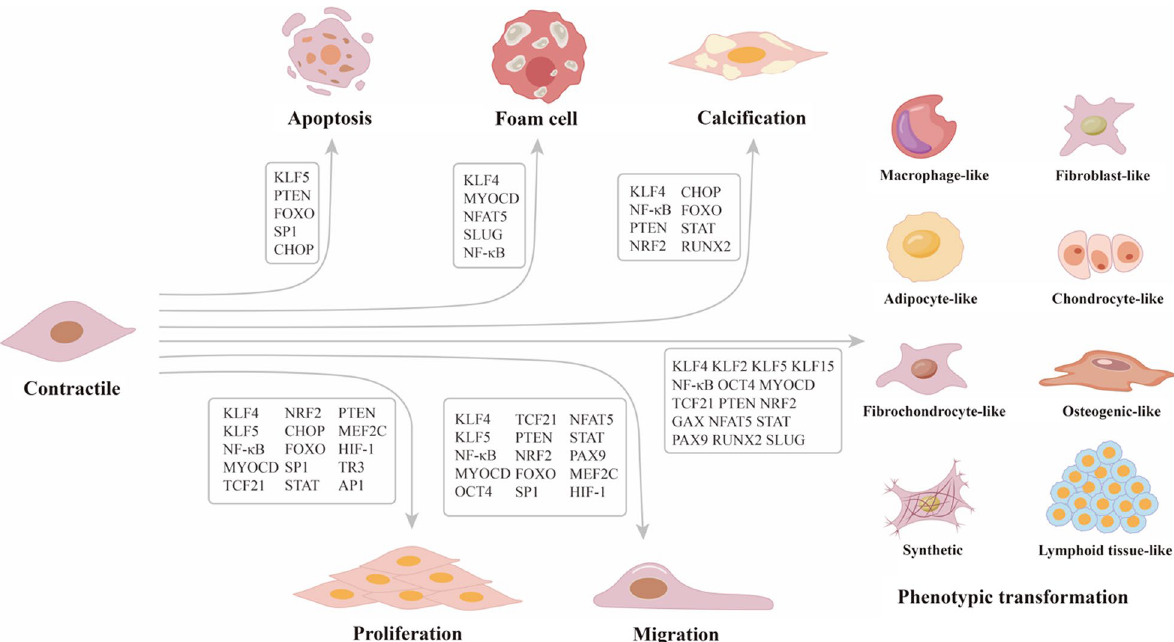
Fig. 1 Schematic of transcription factors involved in VSMC regulation. Through transcription‑related regulatory processes, VSMCs could undergo phenotypic transformation and a series of atherosclerosis‑related pathological processes. For the specific mechanisms of transcription factors during the atherosclerotic lesions, please refer to the main